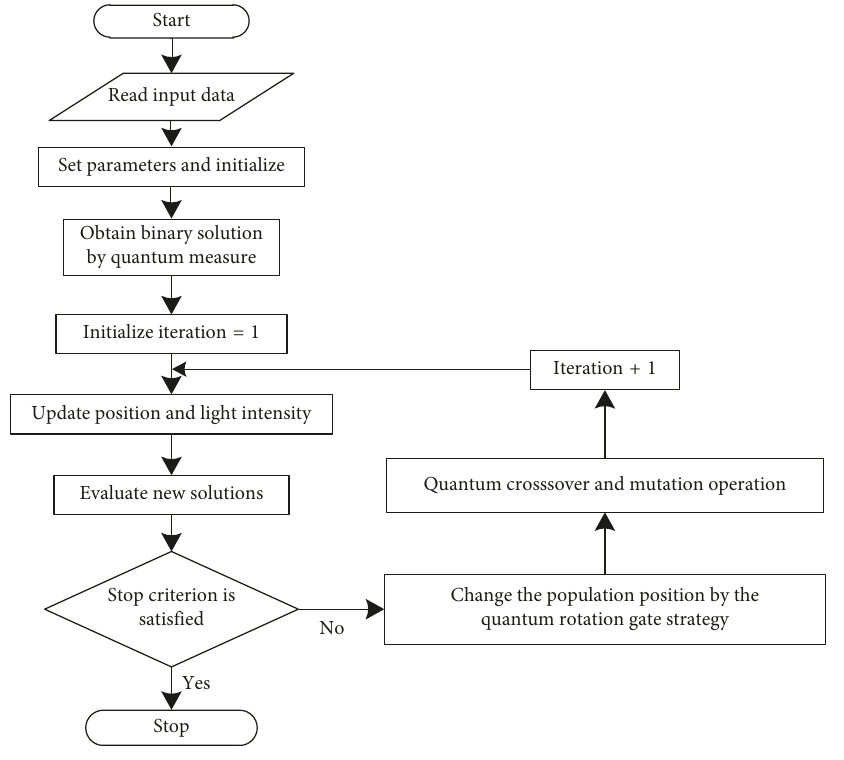
Figure 2: Flowchart of